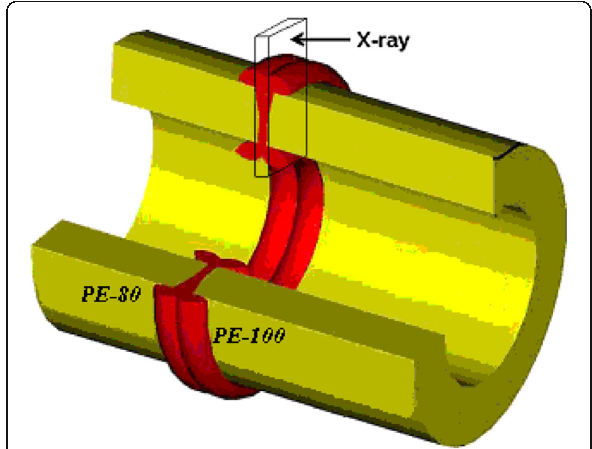
Fig. 2 Scheme of welded joint of PE-80/PE-100 polyethylene pipe types with position of a sample for X-ray study